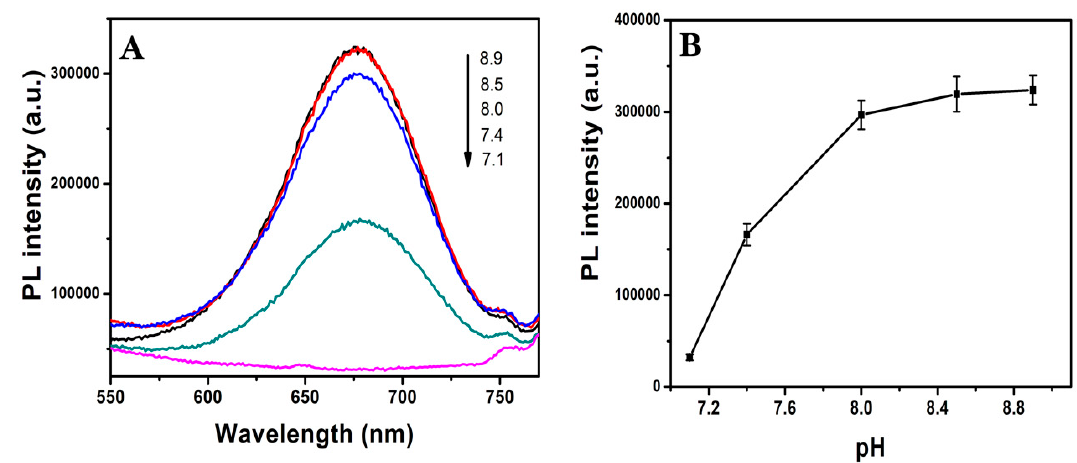
Figure 4. (A) fluorescence spectra of DM FN under different pH and (B) PL intensity of DMFN under different pH on the system.